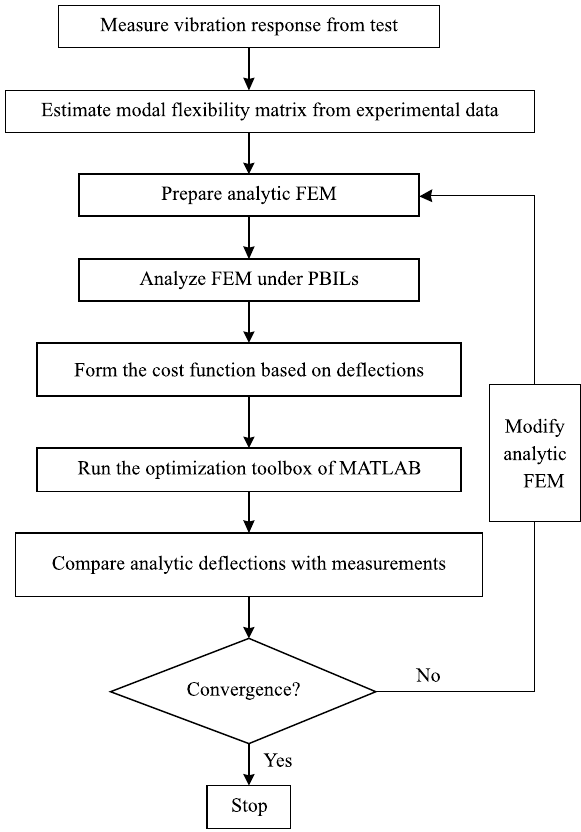
Fig. 1. Flowchart of the identification method based on deflections